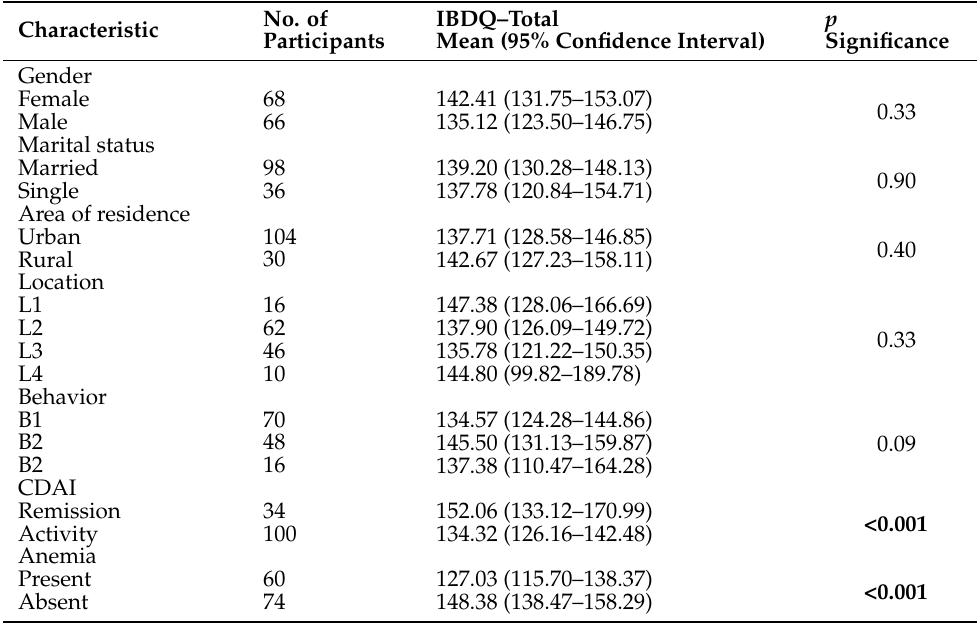
Table 3. Relationship between clinical and demographic characteristics of CD patients and the total score obtained in the IBDQ-32